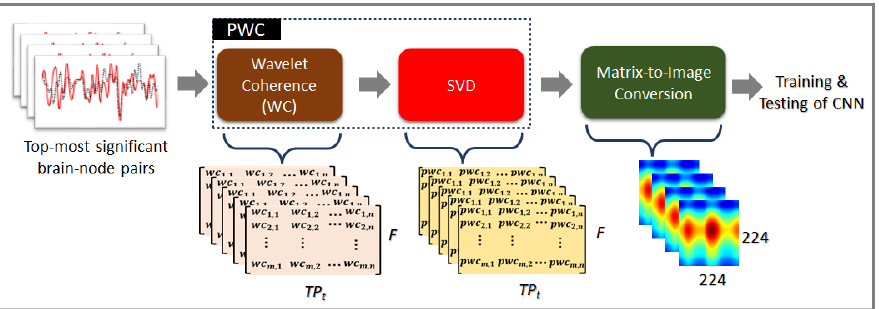
Figure 4. The formation of principal wavelet coherence (PWC) images as the input feature for training and testing of CNN. Here, TP t indicates the length of the BOLD signals, and F is the number of frequency bands from 0.01 Hz to 0.08